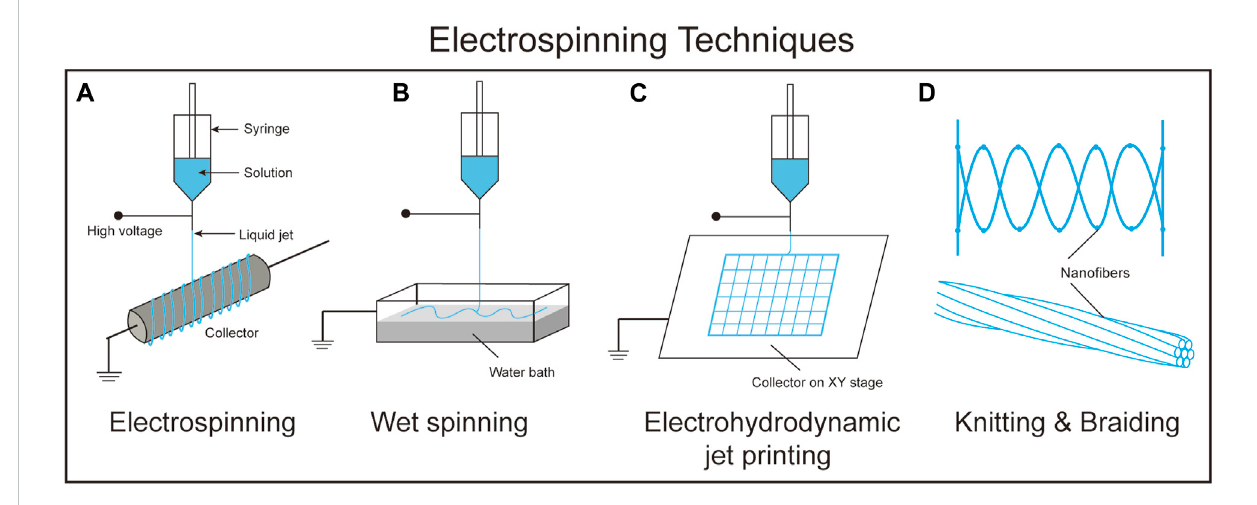
FIGURE 4 A schematic comparison between the different electrospinning techniques. (A) . Electrospinning, (B) . Wet spinning, (C) . Electrohydrodynamic jet printing, and (D) . Knitting and